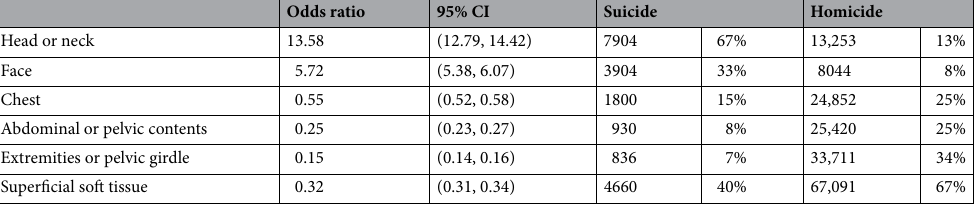
Table 2. Location of injuries for homicide and suicide groups. The odds ratio (OR) and its 95% confidence interval (CI) are shown, along with the number and percent of homicides and suicides who had injuries in each location.